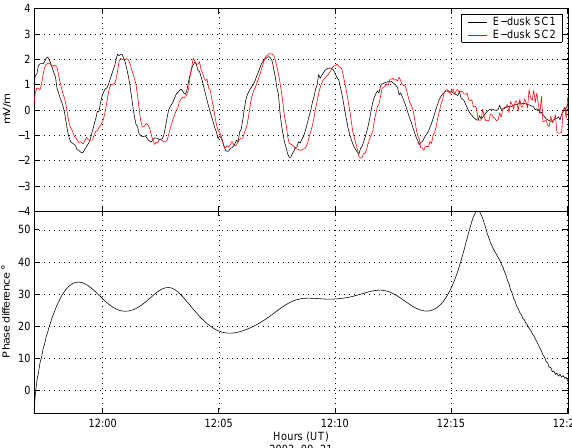
Fig. 2. The top panel shows the duskward electric field for s/c 1 (black line) and s/c 2 (red line), and the bottom panel shows the phase difference between s/c 1 and s/c 2 for the 21 September 2003 event.